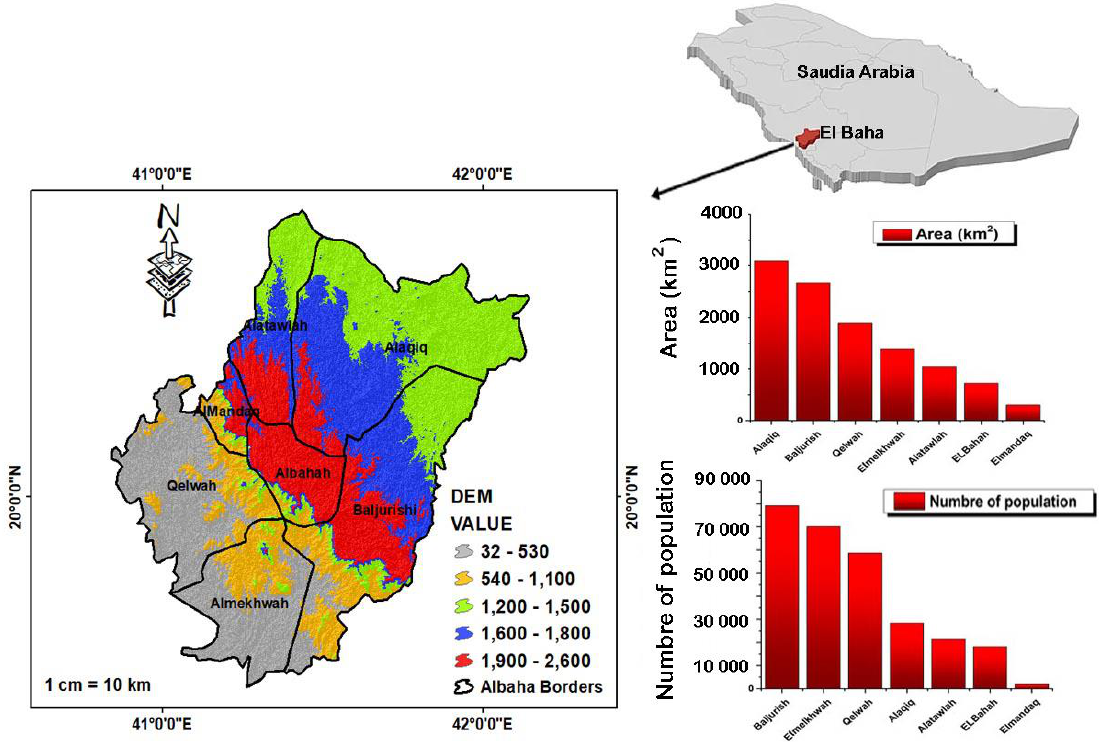
Figure 1. Geographic location, digital elevation model of the study area and an overview of the area and population size of each district within the El Baha region.